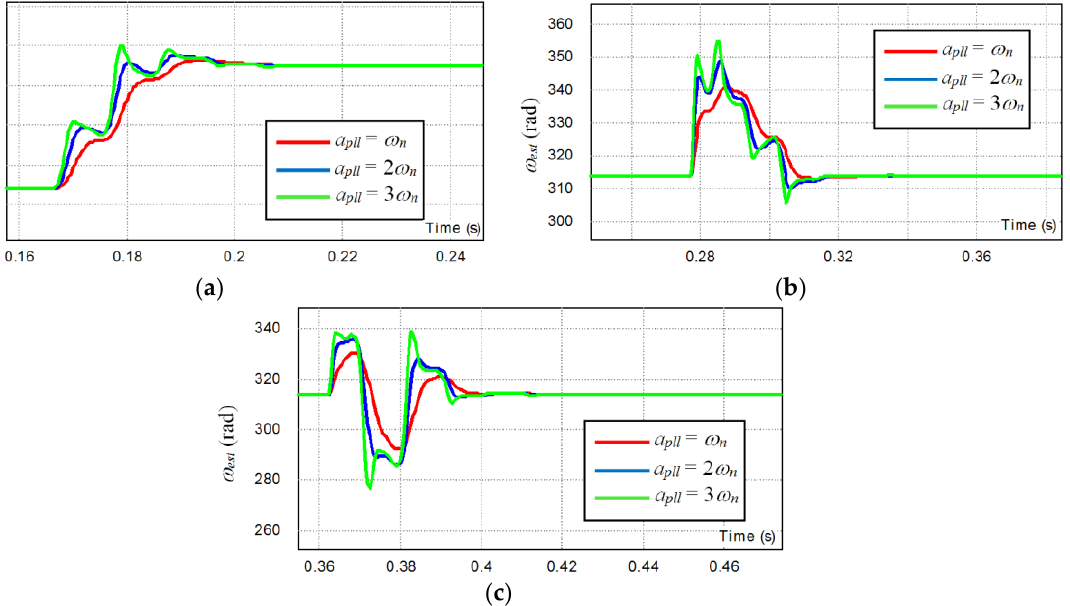
Figure 16. The estimated frequency for ( a ) input signal frequency step variation 31 rad/s, and for ( b ) input signal step phase angle variation 0.5 rad, and ( c ) for DC offset introduced at the FFPLL input, for the FFPLL in Figure 7, for three sets of PLL parameters a pll , nominal FFPLL frequency ω n = 314 rad/s and for input signal frequency ω e = 314 rad/s.